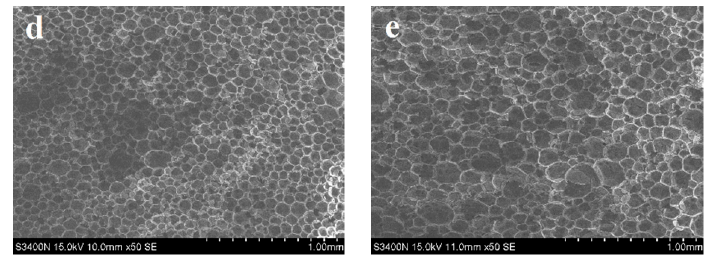
Figure 16. SEM micrographs of CPFs (( a ) 0%; ( b ) 5%; ( c ) 10%; ( d ) 15%; ( e ) 20%).